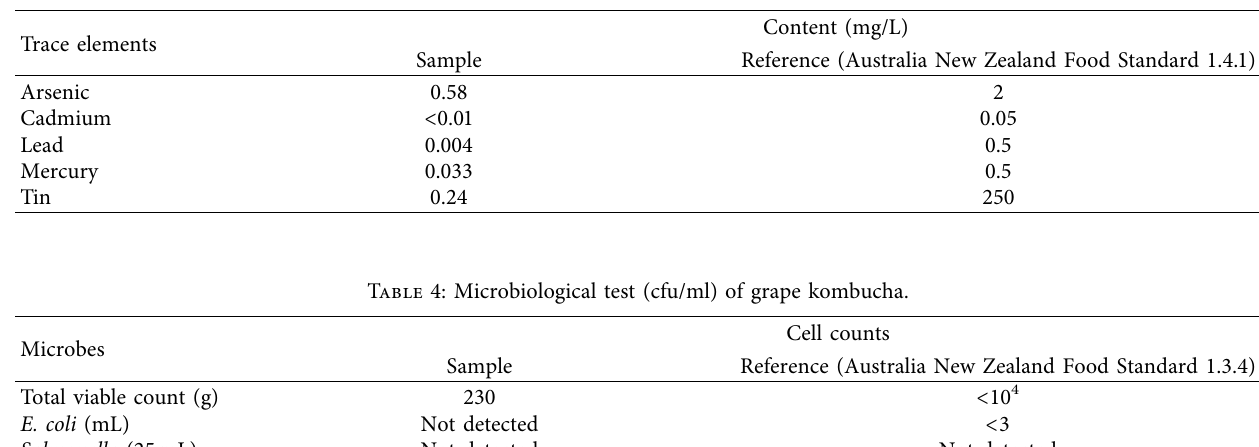
Table 3: Trace elements determined in grape kombucha.